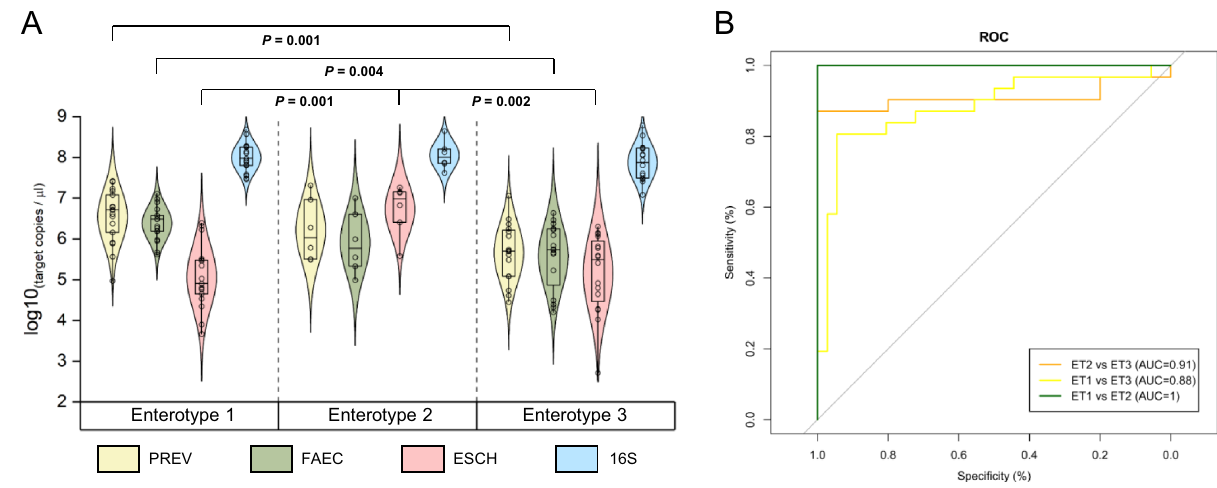
Fig. 3 Taxon-speci fi c and total bacterial qPCR to classify pre-treatment sample in a treatment-relevant category. A Total bacteria and taxon-speci fi c density measured by quantitative PCR (qPCR), by enterotype. Comparison of absolute abundances between enterotype 1 ( n = 17), enterotype 2 ( n = 6), and enterotype 3 ( n = 16) was conducted using two-sided Mann-Whitney tests. The lower and upper bound of each box represent the 25th and 75th percentiles, respectively, and the line within indicates the median. The whiskers represent the minimum and maximum values. B Classi fi cation sensitivity and speci fi city into the enterotype using qPCR values. PREV Prevotella genus qPCR target, FAEC Faecalibacterium genus qPCR target, ESCH Escherichia coli qPCR target; 16S total bacteria qPCR